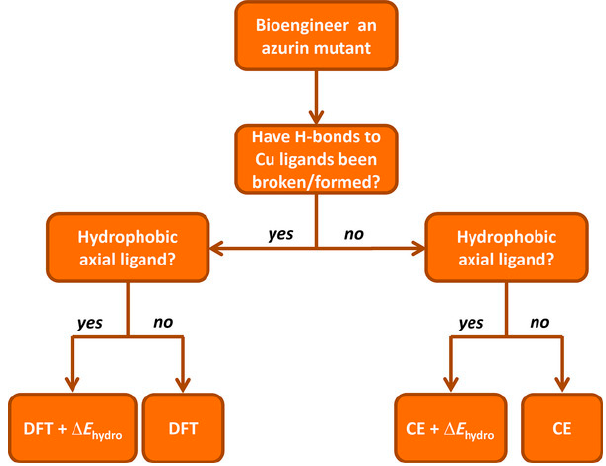
Figure 11. Flow diagram used to decide which computational method to use to compute the predicted reduction potential of an azurin mutant (CE = continuum electrostatics). Reprinted with permission from [140]. Copyright (2017) Wiley-VCH.